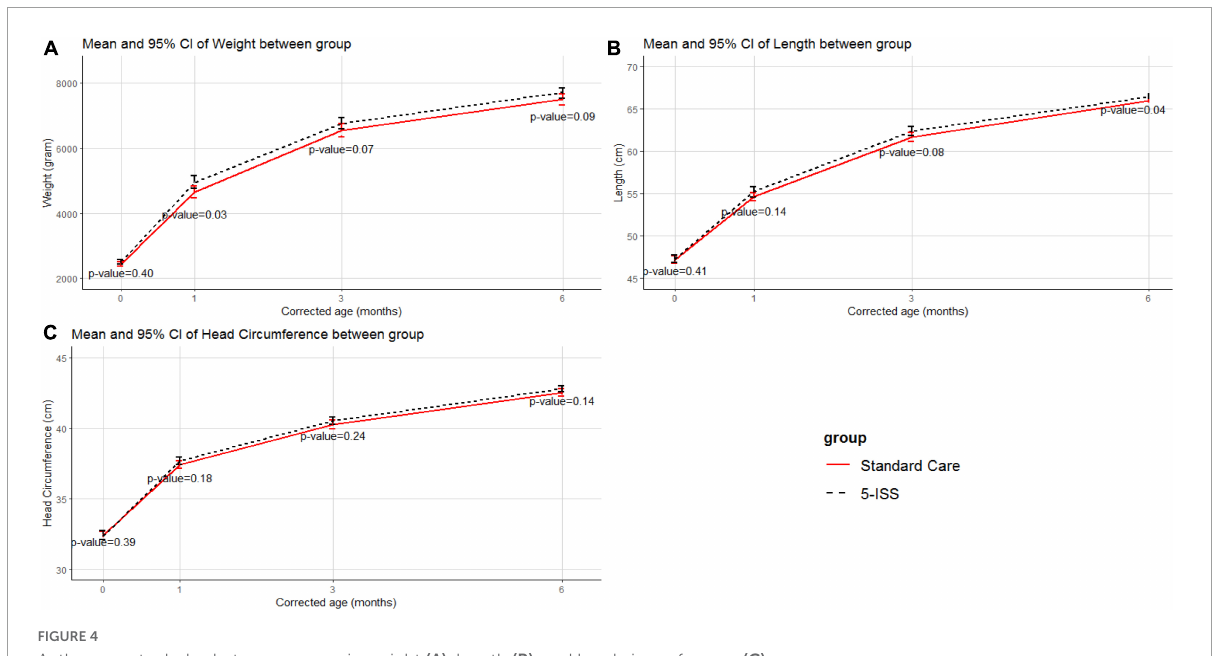
FIGURE4 Anthropometry Index between groups in weight (A) , length (B) , and head circumference (C) .